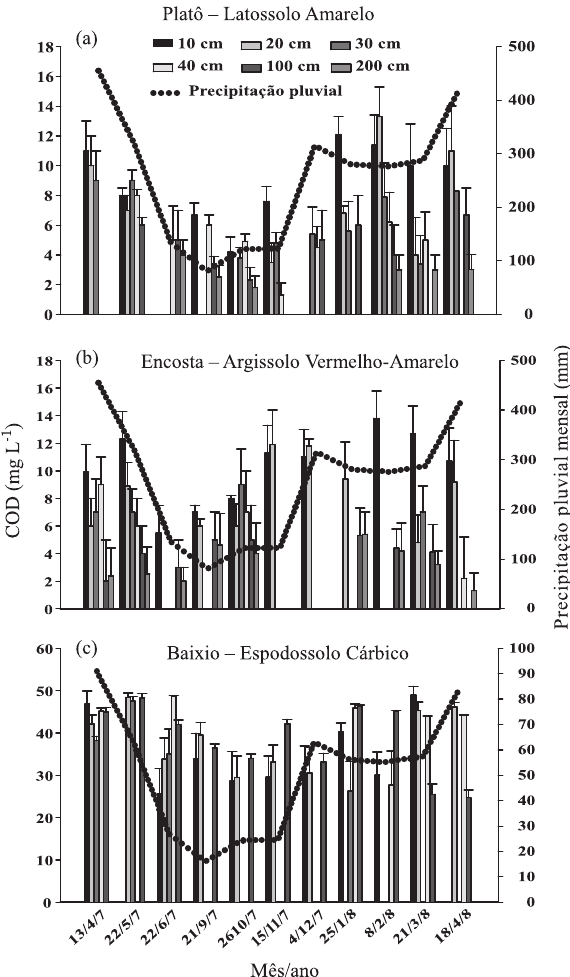
Figura 1. Variação do Cod em profundidade as- sociada à precipitação pluvial sob floresta primária, em diferentes posições topográficas: platô (a), encosta (b) e baixio (c). as barras nos gráficos representam as coletas de Cod realizadas, por profundidade, com seus res- pectivos desvios-padrão, as datas de coleta e as profundidades; a linha pontilhada mostra a precipitação pluvial de cada período.